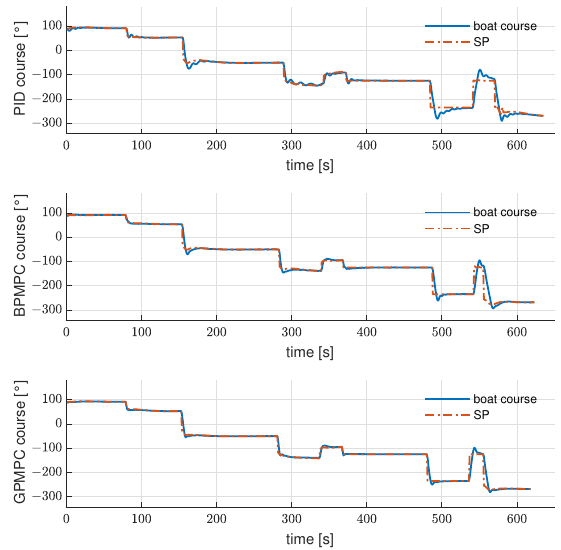
Figure 21. Heading change under calm water. The top graph shows the response curve of heading change under PID control, the middle graph shows the response curve of heading change under BPMPC control, and the bottom graph shows the response curve of heading change under GPMPC control, the solid blue line is the actual heading and the dashed orange line is the target heading.